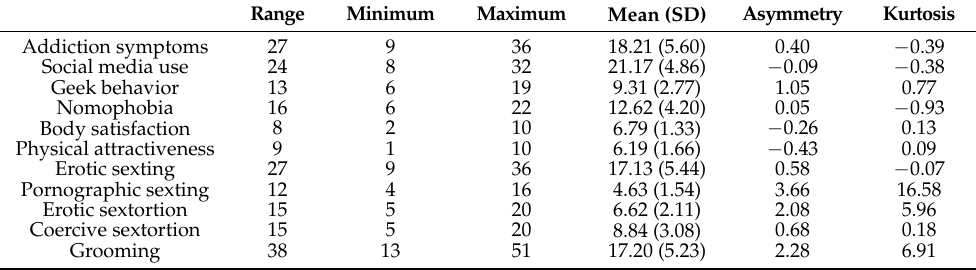
Table 1. Descriptive analyses of the studied